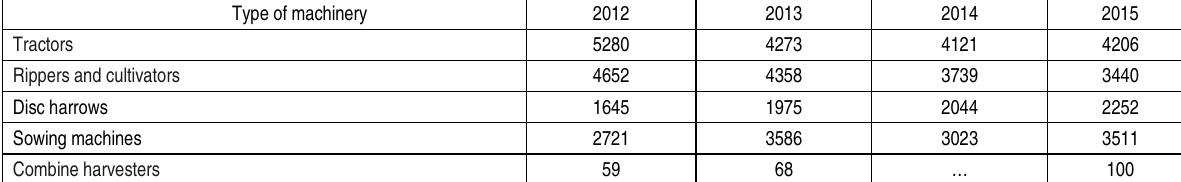
Table 6. Production of tractors, combine harvesters and agricultural machinery in Ukraine,